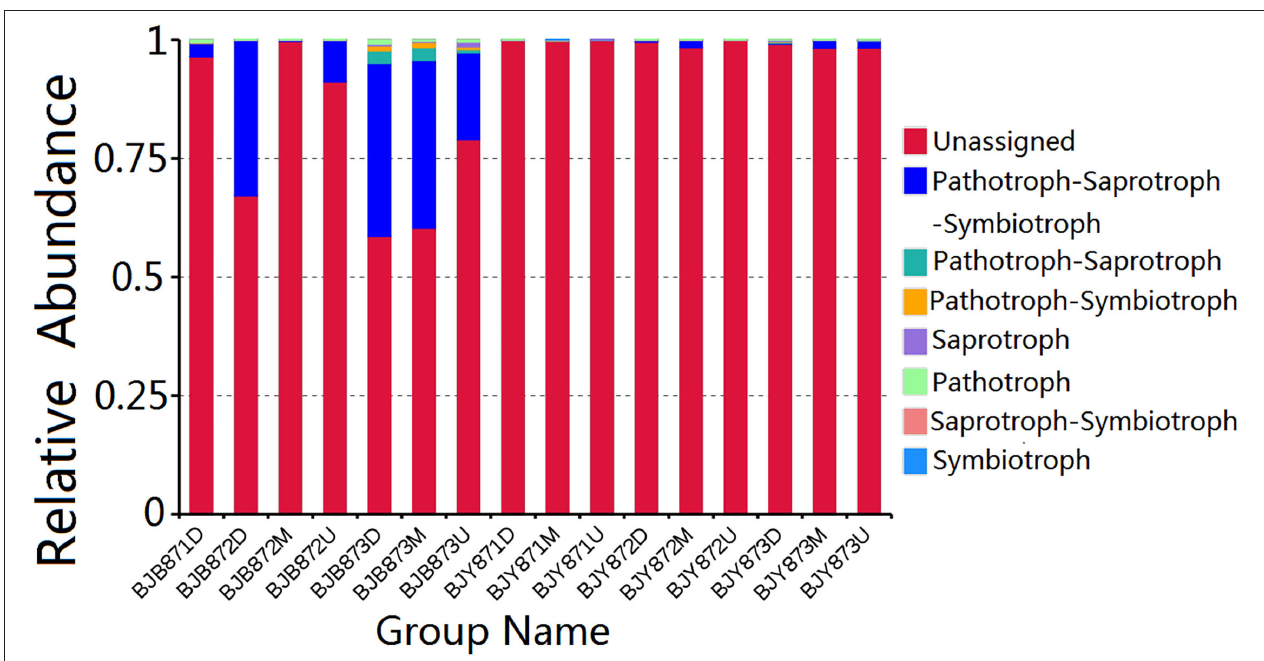
FIGURE 8 | Variation of bacterial functional categories based on qualified sequences analyzed by PICRUSt. The KEGG pathway annotation of genes predictions from 16 samples (A) . The cluster heatmap at the KEGG level 2 function (B) .